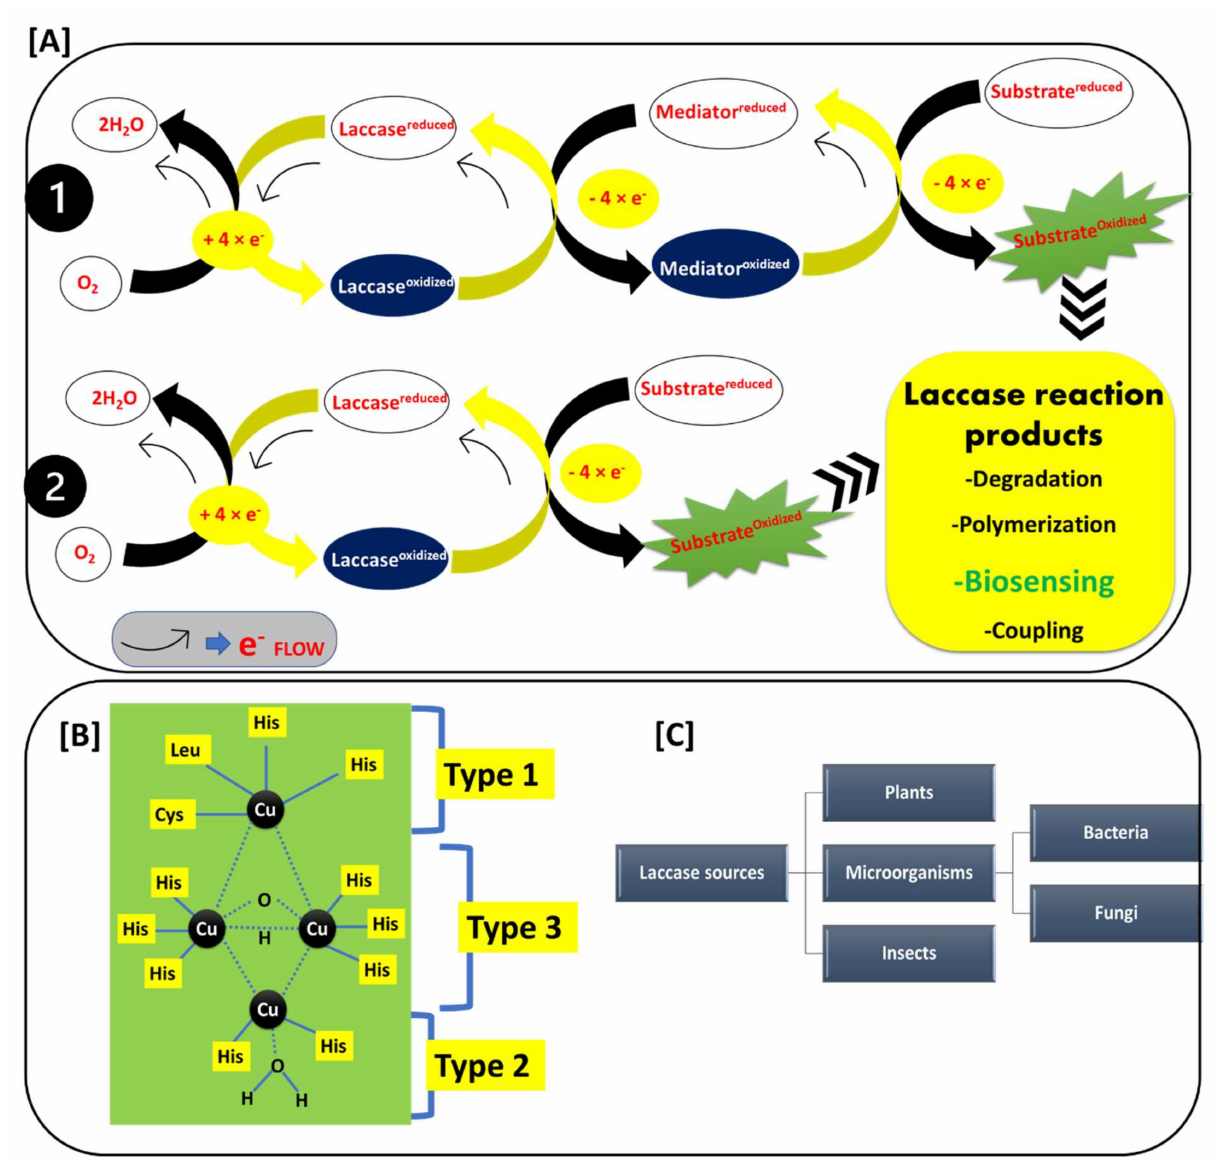
Figure 2. ( A ) Reaction mechanism of the laccase-catalyzed reactions: 1. mediator dependent and 2. mediator independent reactions, and laccase reaction products; ( B ) Structure of the laccase active site Type 1, Type 2, and Type 3; and ( C ) Occurrence of laccase among various